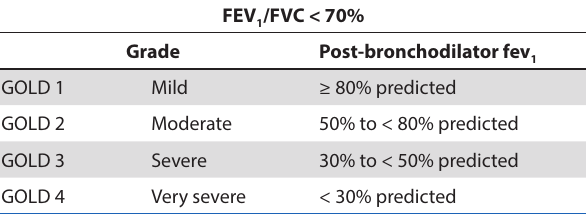
Table 2: Gold classification of airflow